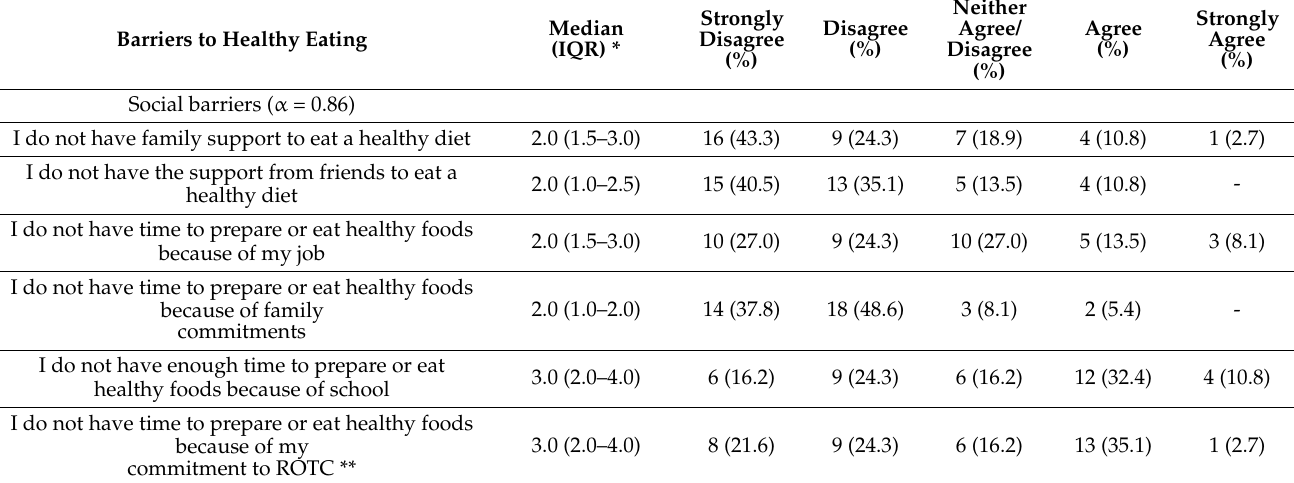
Table 2. Perceived barriers